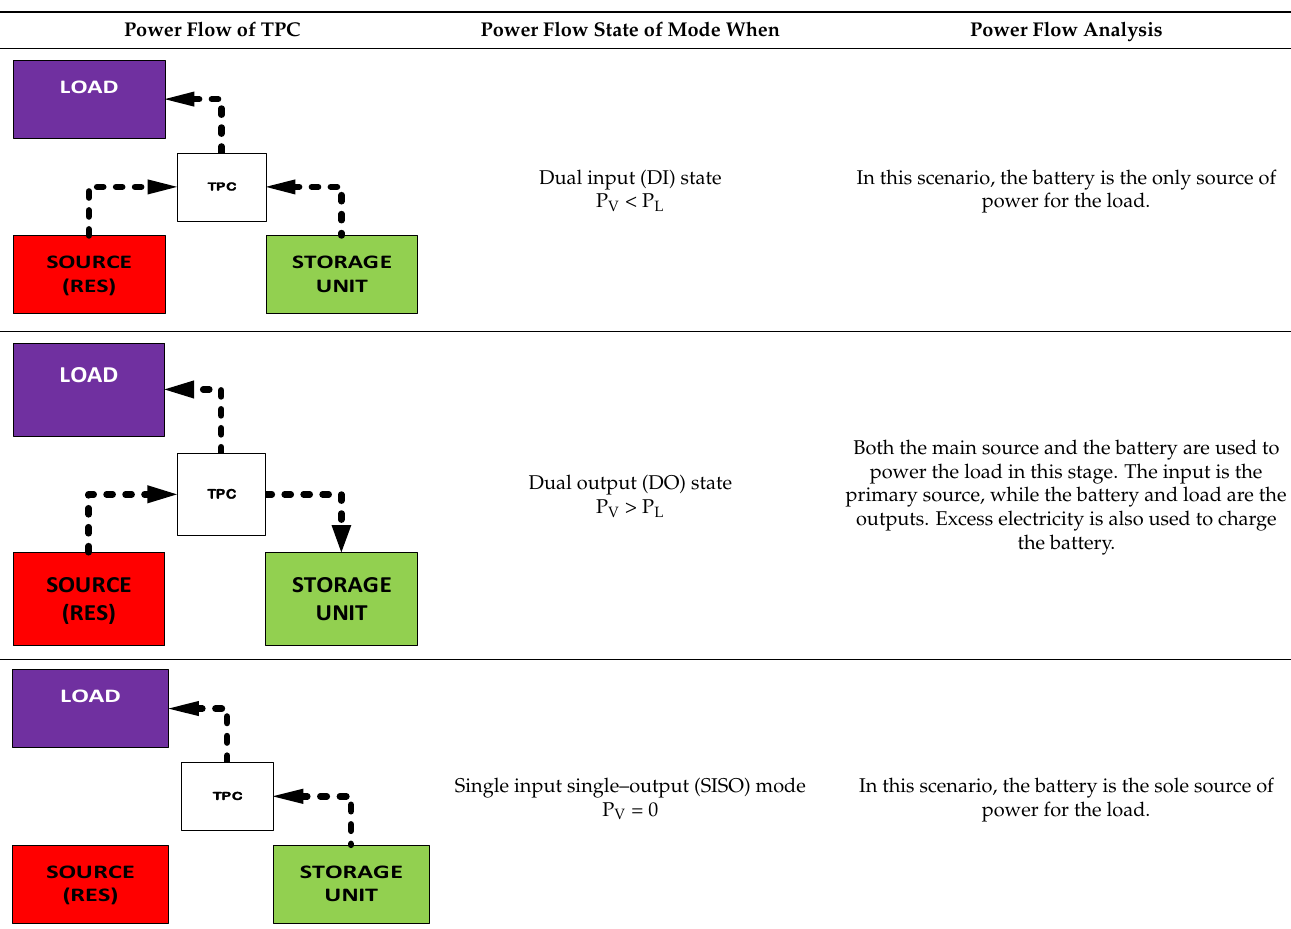
Figure 25. General classification of a non-isolated MPC.